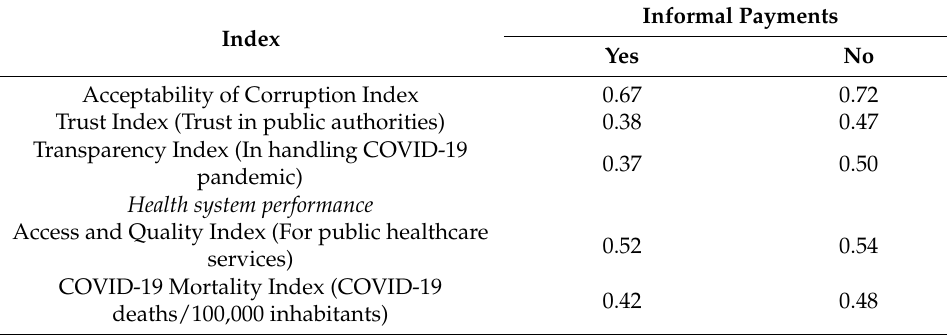
Table 3. Informal payments and institutions ( n = 10,859;